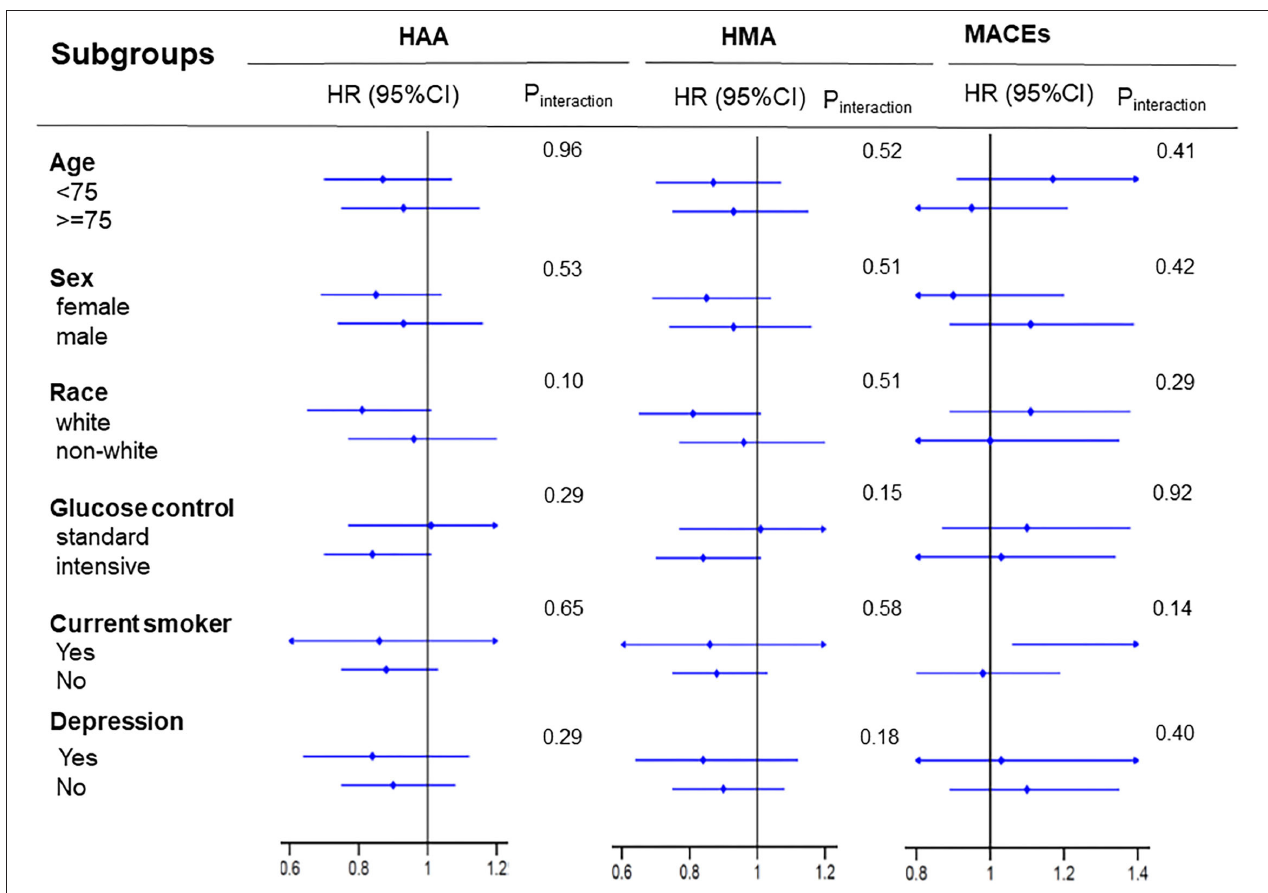
FIGURE 3 | Subgroup analysis for the selected health events. Each stratification was adjusted for all factors in Model 4, except for the stratification factor itself. MACEs, major adverse cardiovascular events; HAA, hypoglycemia requiring any assistance; HMA, hypoglycemia requiring medical